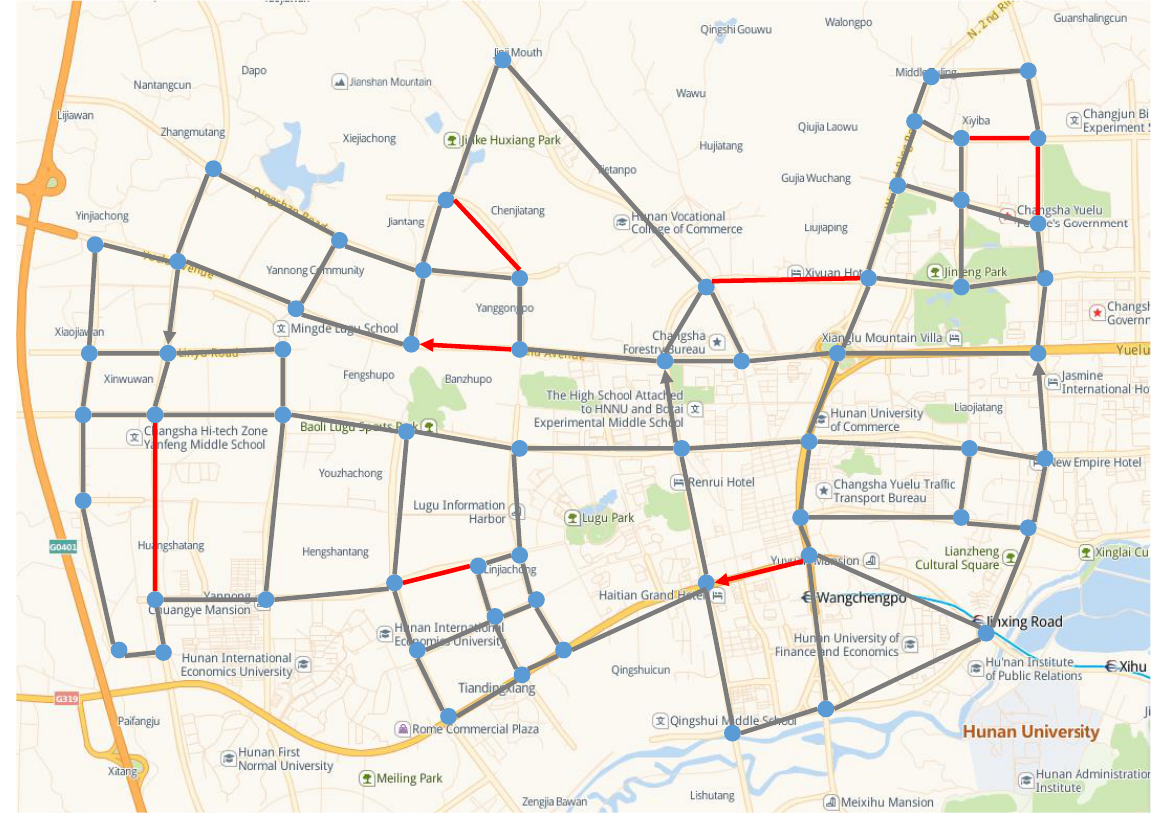
Figure 13. Simplified road network in a selected area of Changsha City.